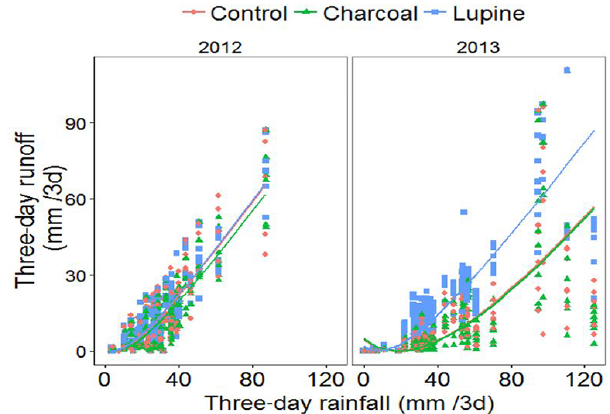
Figure 7. Effect of charcoal amendment and deep-rooted lupine on 3-day soil water storage: 3-day rainfall vs. 3-day runoff with SCS- CN fitted lines fitted using the SCS-CN equation (Rallison, 1980). Fitted 3-day storages values in 2012 were 22, 26, and 21mm for control, charcoal, and lupine, respectively, and, in 2013, 93, 94, and 40mm for control, charcoal, and lupine,